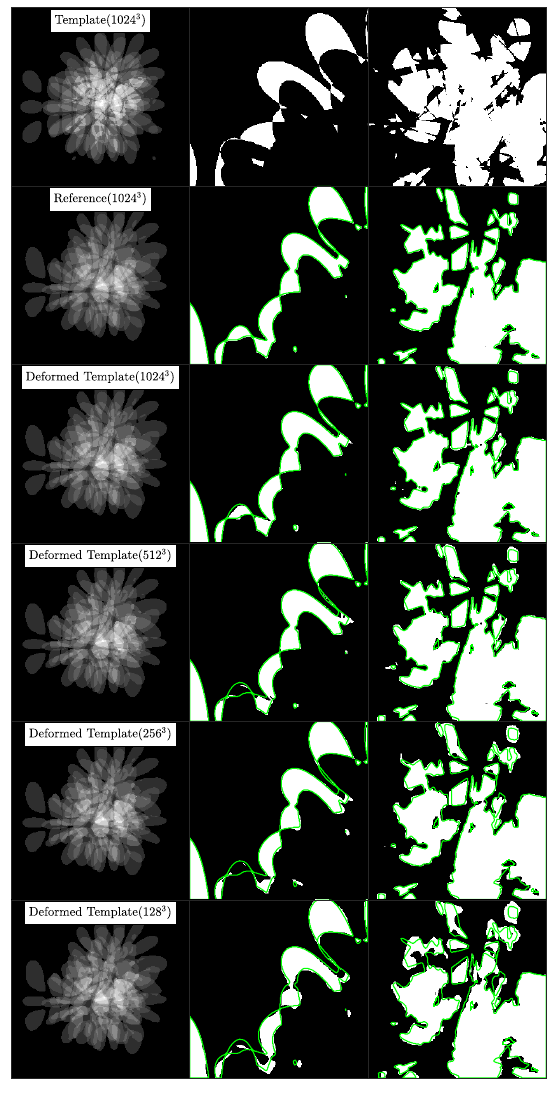
Figure 4. Experiment 2A: Visualization of registration results for case 1. In column 1, from top to bottom, we visualize the template, reference and deformed template images for registrations done at different resolutions. These images correspond to the runs #1-4 in Table 5. The value in the parentheses in column 1 indicates the resolution at which registration was done. The visualization is done at the original resolution n = ( 1024,1024,1024 ) . In columns 2 and 3, we visualize cropped portions of the images shown in column 1 for specific label values. In column 2, we show label 1, in column 3, we show the union of labels with intensity value ≥ 5. Note that higher label values have smaller volumes and more fine-grained features. We plot the label boundaries for the reference image in green to visualize the registration